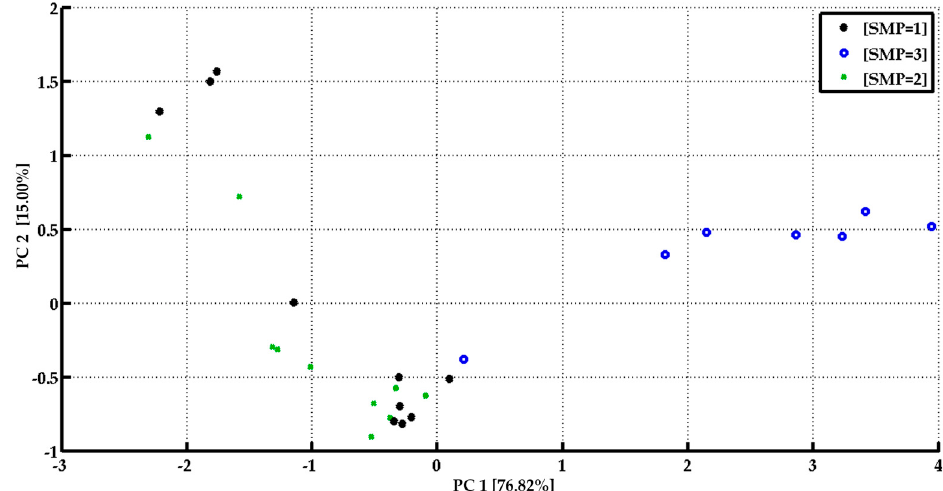
Figure 16. PCA score pot of the analysis carried out on samples belonging the three different individuals’ microbiota.